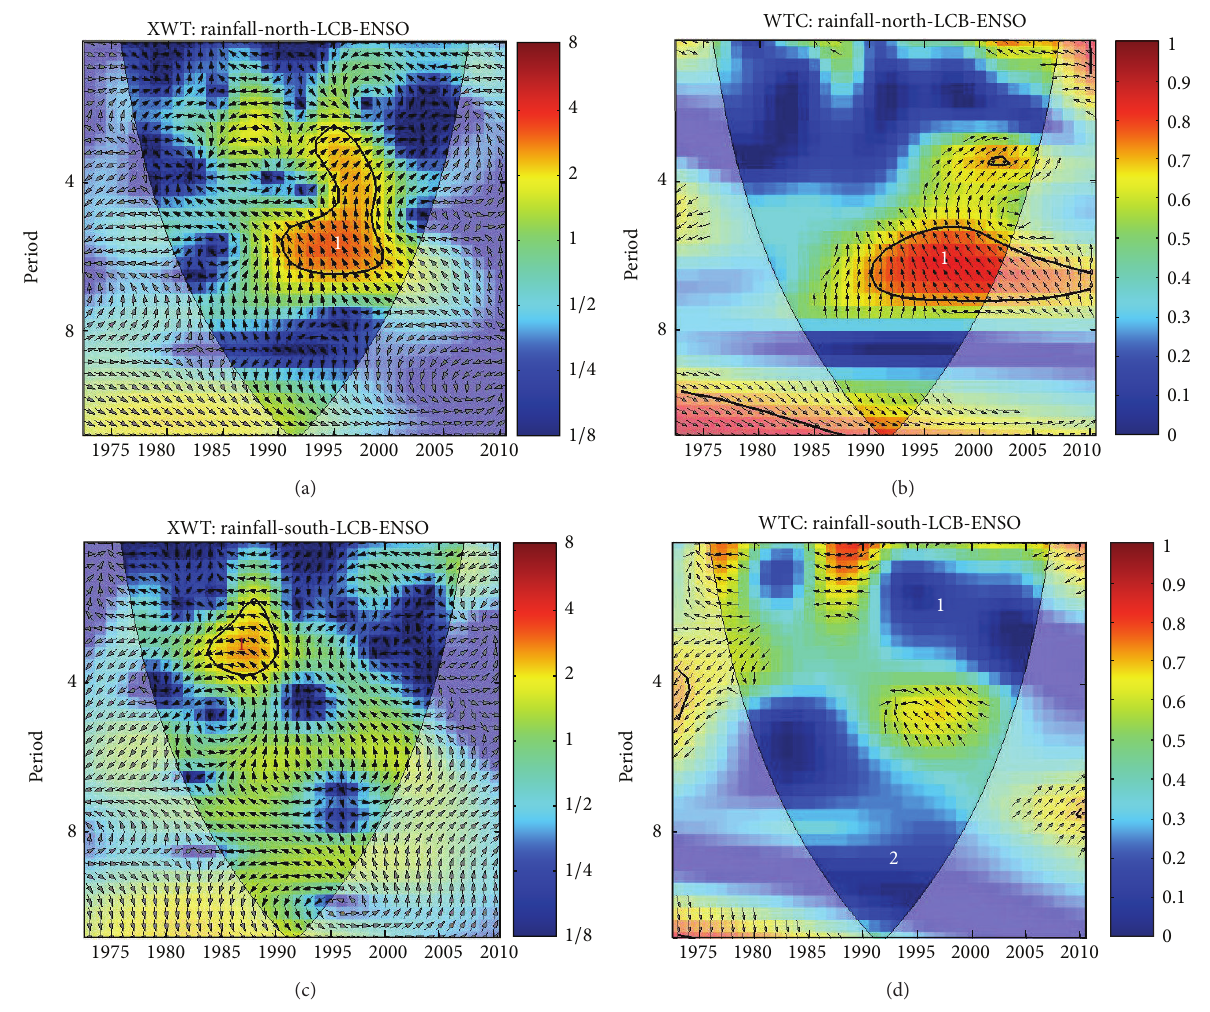
Figure 7: Precipitation and ENSO cross-wavelet spectra: (a) northern LCB; (b) southern LCB and wavelet coherence; (c) northern LCB; and (d) southern LCB. The thick contour enclosed regions are greater than 95% confidence for a red-noise process. The thin solid line indicates the “cone of influence,” where edge effects become